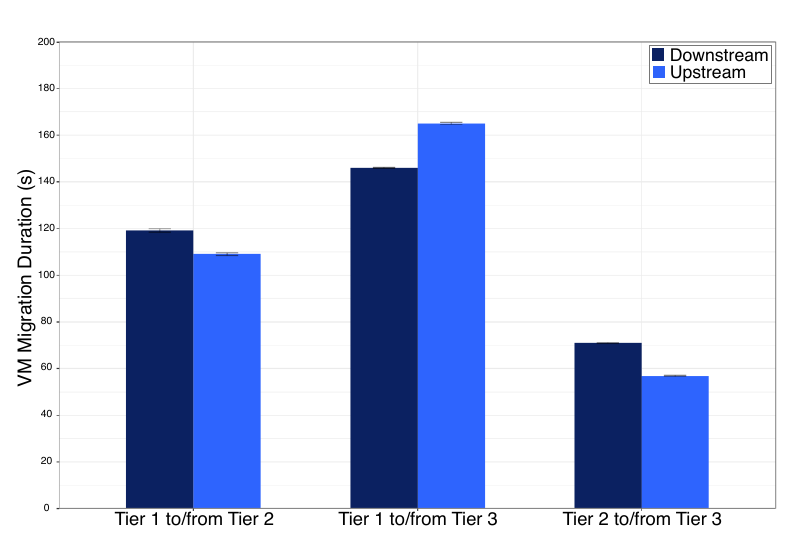
Figure 7. Time Need for Live VM Migration Between Tiers of the Proposed